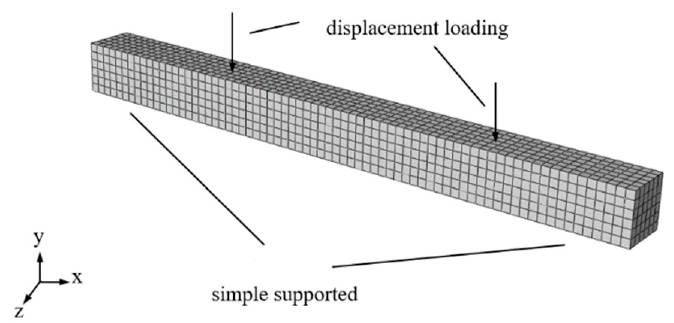
Figure 2. Numerical model of beam.